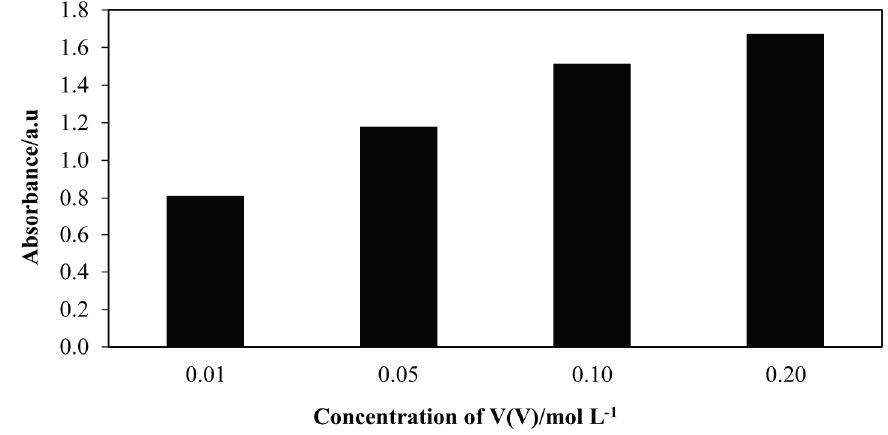
Figure 7. Absorbance spectra for FHA-V(V) complex after aminolysis reactions using different concentrations of V(V) ion solution. Reaction conditions: Crude palm oil, 6 mmol; hydroxylamine hydrochloride, 2 mmol; TL lipase, 20.0 mg; hexane, 3 mL; deionized H 2 O, 3 mL; temperature, 70 °C; shaking rate, 150 rpm; reaction time, 60